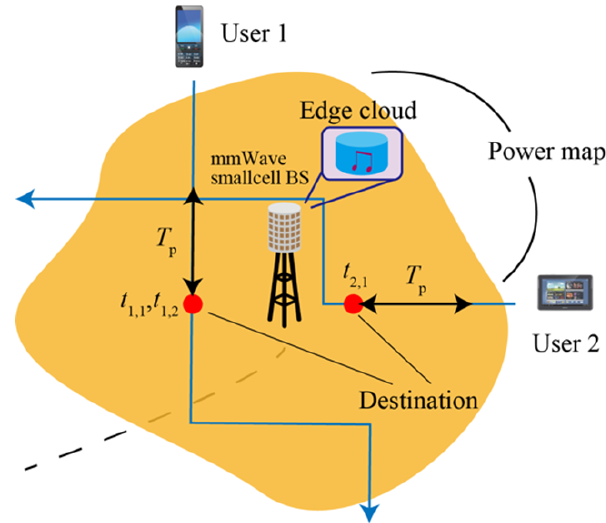
Figure 6. Illustration of